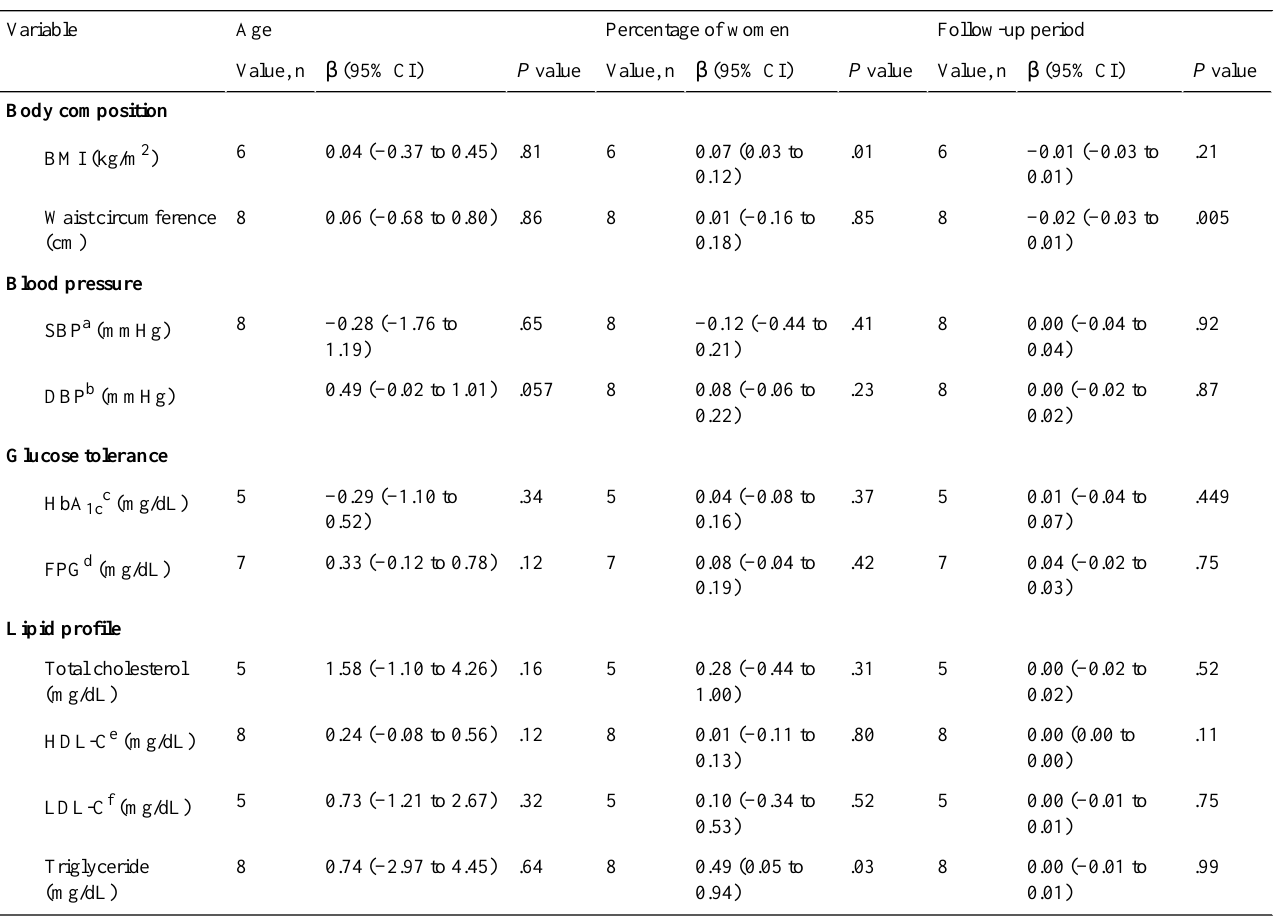
Table 4. Meta-regression findings.